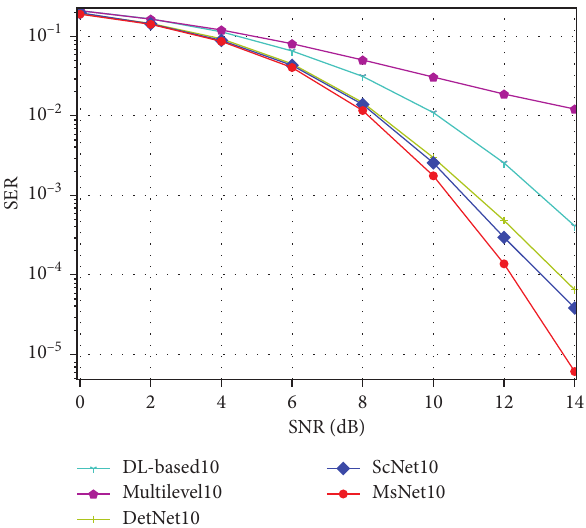
Figure 6: SER comparison of various detectors: M � 32, N � 64, and